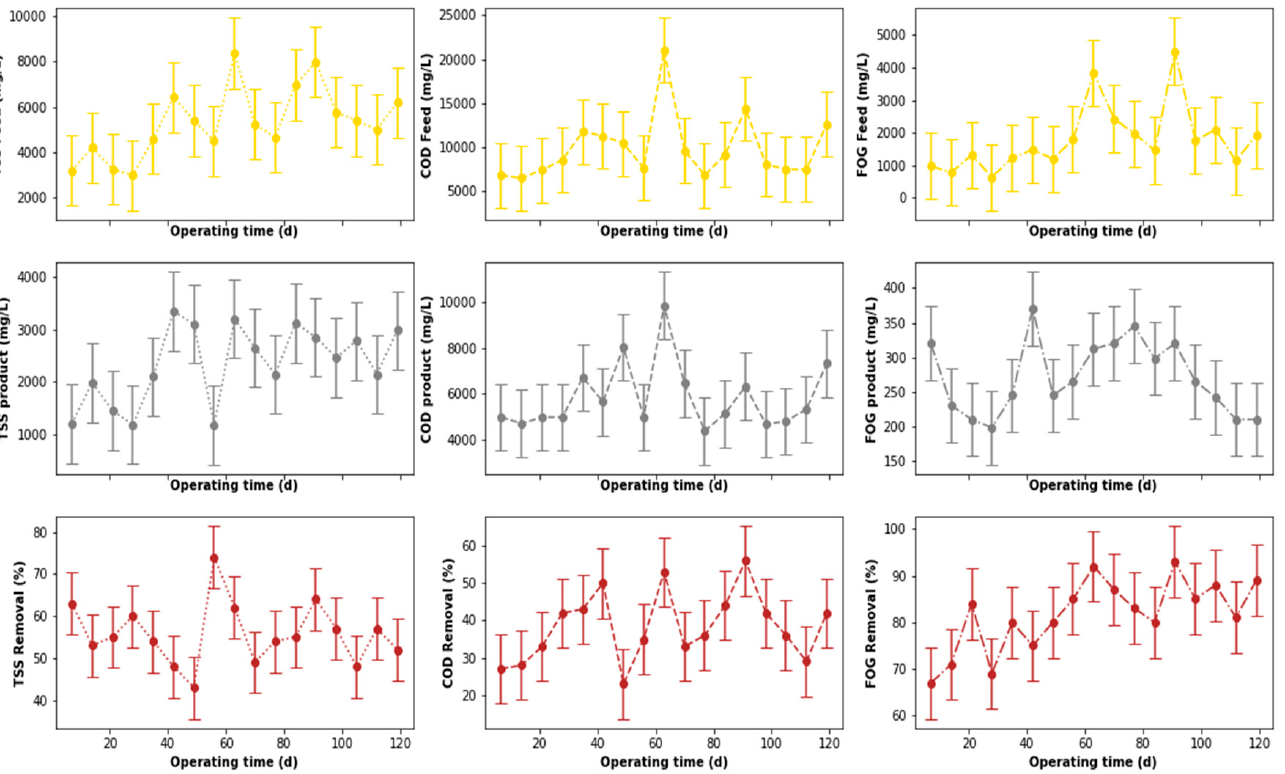
Figure 7. Performance of PSW pre-treatment stage before outliers’ detection and replacement.